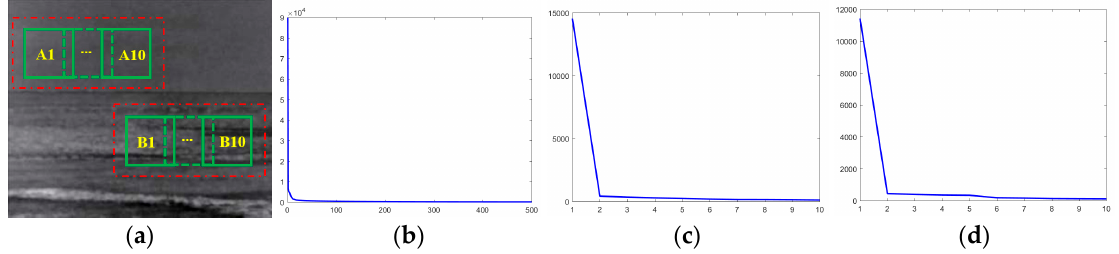
Figure 1. Illustration of the low-rank property of the background patch-image. ( a ) Representative background image and the clipped local patch-image (denoted by the red window). ( b – d ) Singular values of the global background patch-image, the clipped local patch-image A and B, respectively.